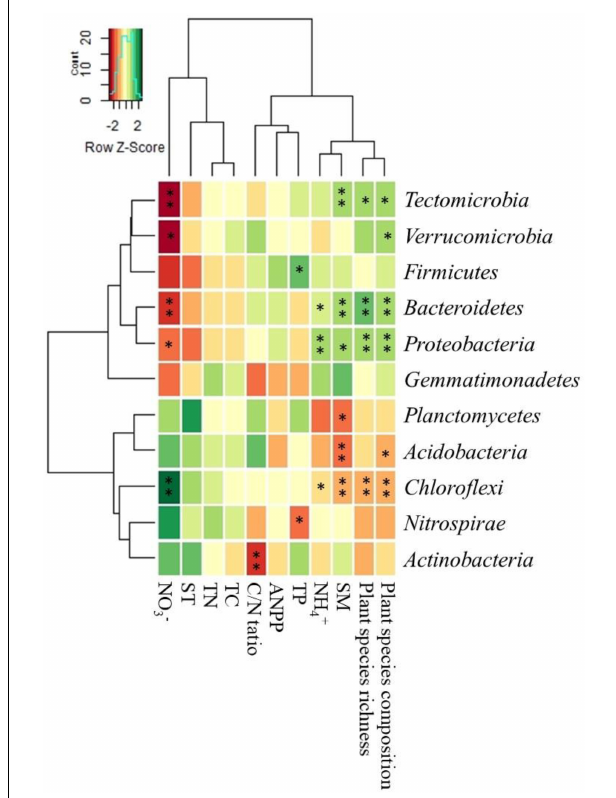
FIGURE 4 | Correlation heat map of soil and vegetation properties with relative abundance of the top eleven bacterial phyla. The right side of the legend is the color range of R -values. See Table 1 for abbreviations. The values of p < 0.05 are marked with “ ∗ .” The values of p < 0.001 are marked with “ ∗∗